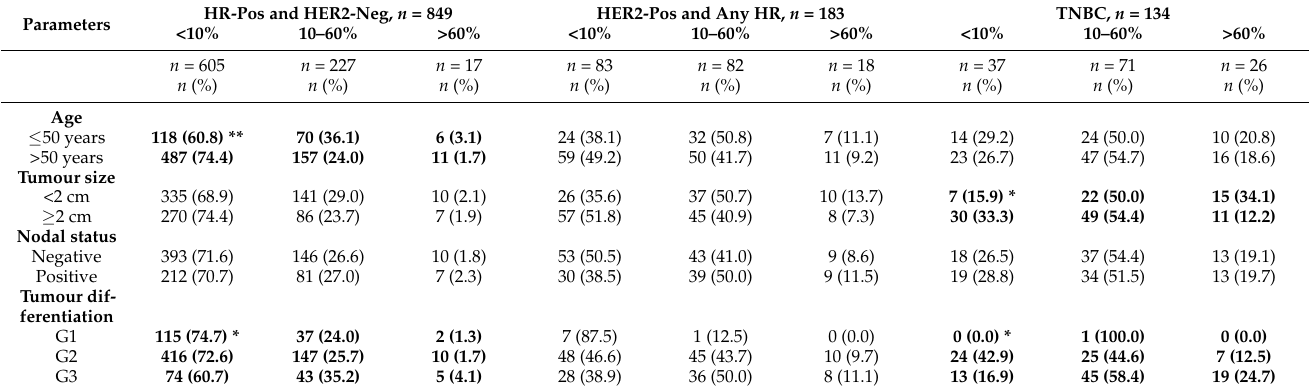
Figure 1. CONSORT diagram: patients with TIL evaluations ( n = 1166) and in the subgroups according to HR and HER2 expressions. Abbreviations: hormone receptor (HR), human epidermal growth factor receptor 2 (HER2), triple-negative breast cancer (TNBC). The median age of the TILs cohort was 61 years, but patients with HER2-positive tumours and TNBCs were younger (median age 56 years) than the HR-positive and HER2-negative patients (median age 62 years), the tumours were larger and less differ- entiated and the patients had more lymph node involvement than patients with an HR-positive status (Table 1). In 36 cases (3.1%), patients in the TILs cohort did not receive the recommended therapy due to patient choice or frailty. Table 1. Patients’ characteristics and histopathological parameters regarding TIL evaluations of the tumours at the time of diagnosis.